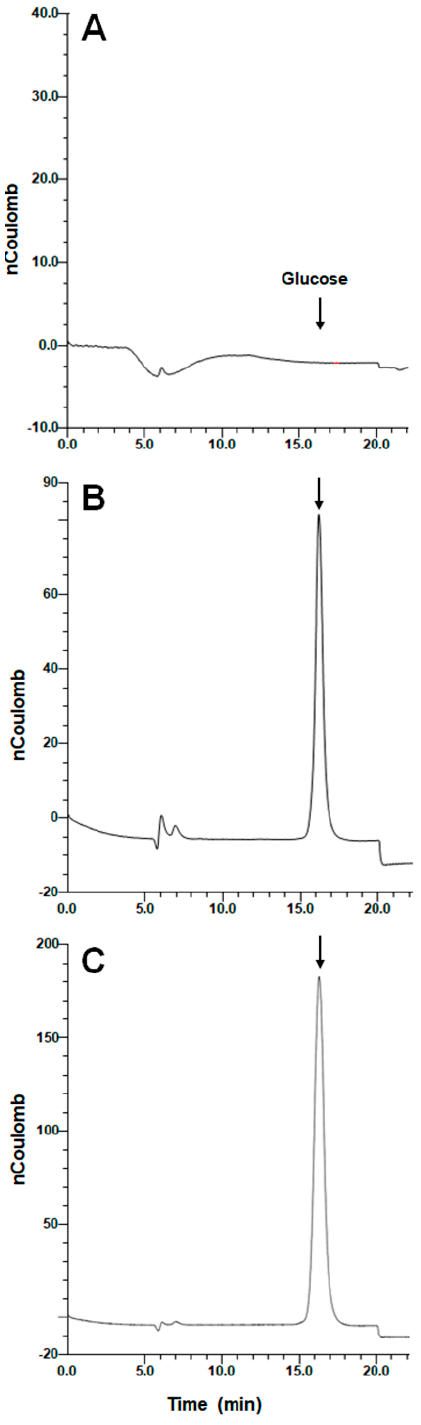
Figure 2. Detection of glucose in the Sporothrix schenckii cell wall N -linked glycan core. The N -linked glycans were trimmed from the yeast-like cell wall by incubating with 25 U of endoglycosidase H, the released N -linked glycans were filtrated in a 3 kDa-exclusion filtration unit, and the eluted material was hydrolyzed with recombinant α -glucosidase and analyzed by high-performance anion-exchange chromatography with pulsed amperometric detection. The arrow indicated the elution time of glucose. ( A ) A sample from the WT strain; ( B ) a sample from the ROT2 -silenced mutant strain HSS34; ( C ) a sample from the ROT2 -silenced mutant strain HSS38. Chromatograms are representative of experiments performed three times per